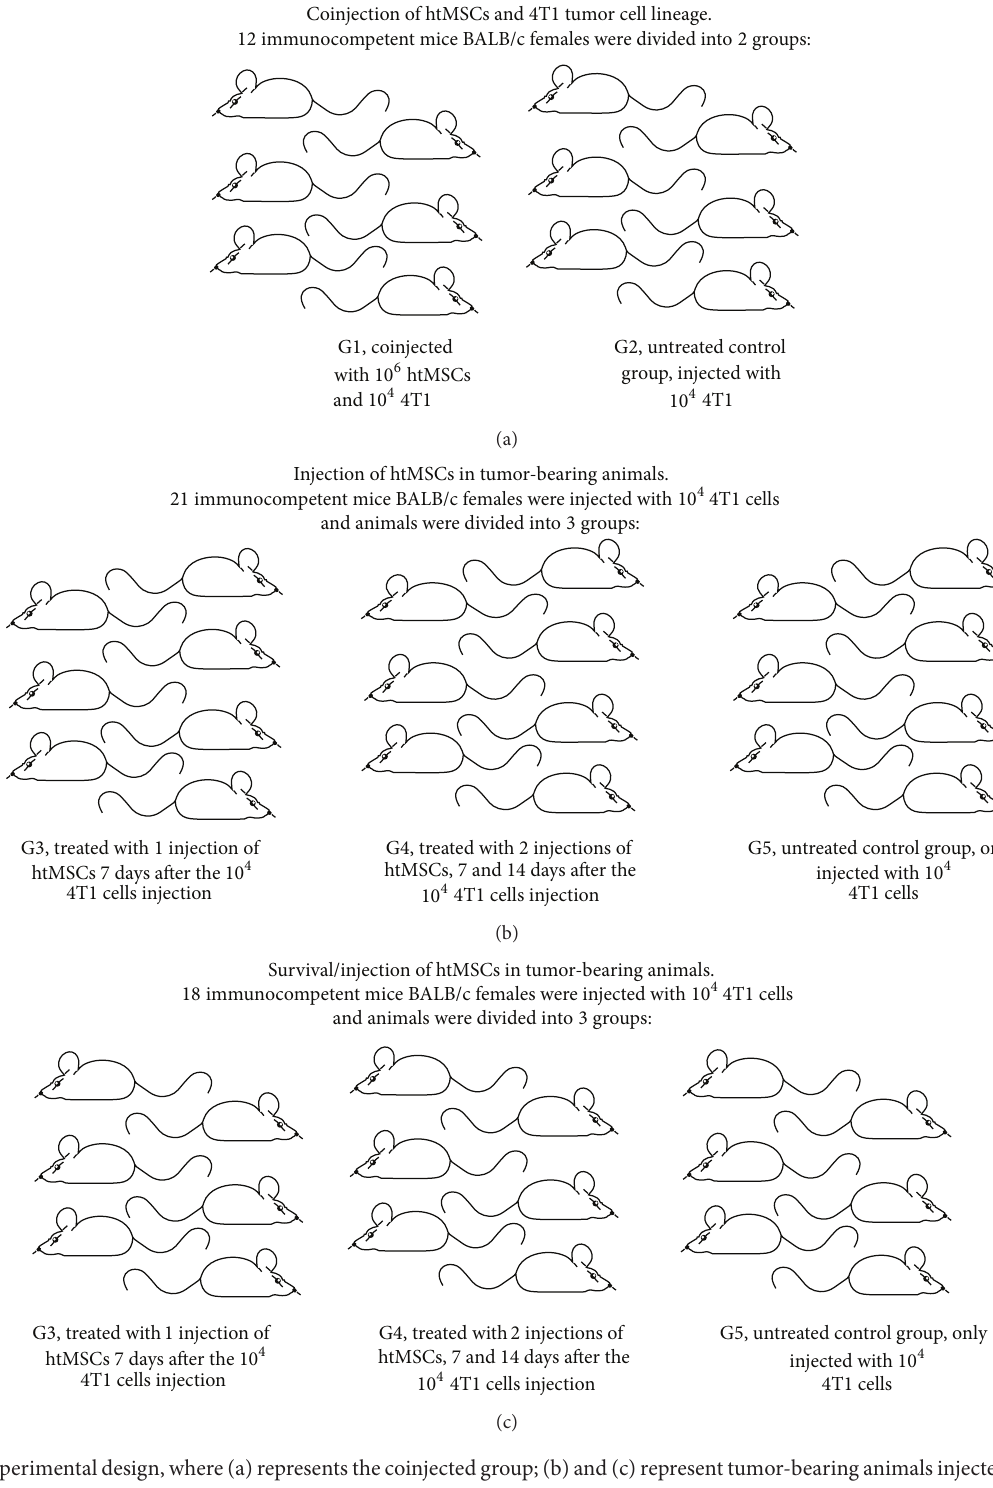
the inoculation of 4T1 cells; G4, treated with 2 intraperitoneal injections of 10 6 htMSCs, 7 and 14 days after the inoculation of 4T1 cells; G5, untreated control group, only injected with 4T1 cells (Figure